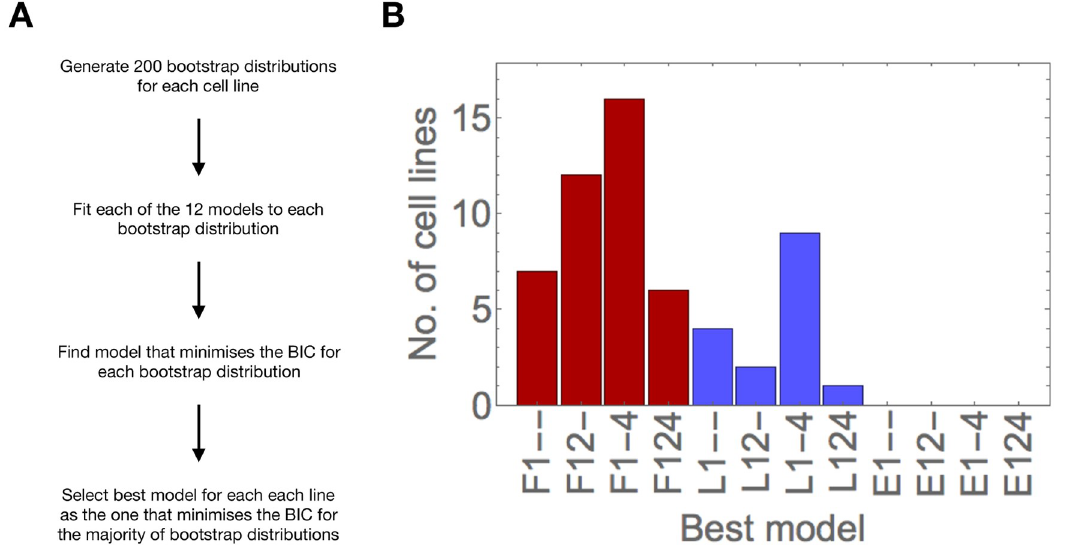
Fig 4. Models assuming a flat fitness function best explain the data for most cell lines. A—Procedure for model selection. B— Models with a flat fitness function explain the data for most cell lines. Number of cell lines for which the corresponding model was selected as the best. The fitness function of the models is indicated in red (flat) or blue